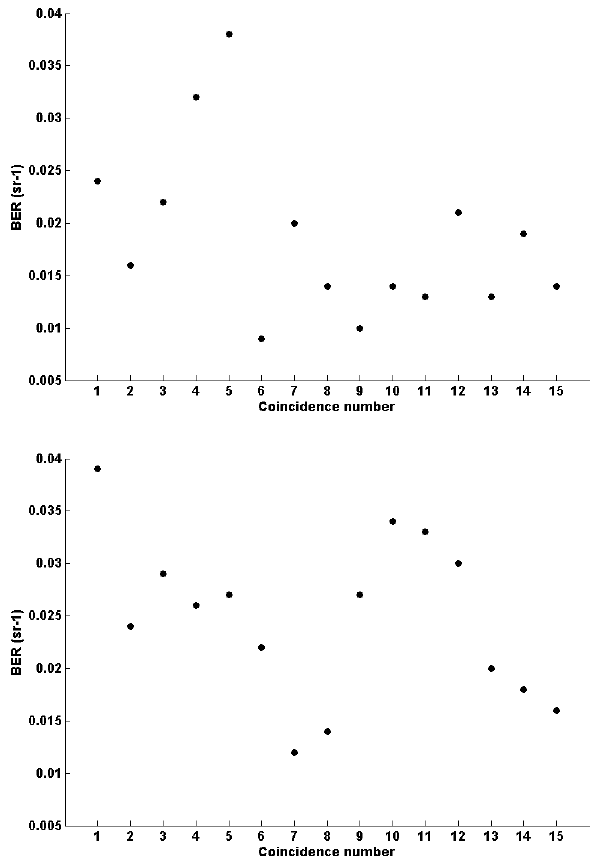
Figure 7. Column backscatter to extinction ratio (BER in sr − 1 ) derived from WALI temporal evolution for the different inter- comparisons exercises during HyMeX (up) and ChArMEx (down) experiments. Abscissa represents the CN.